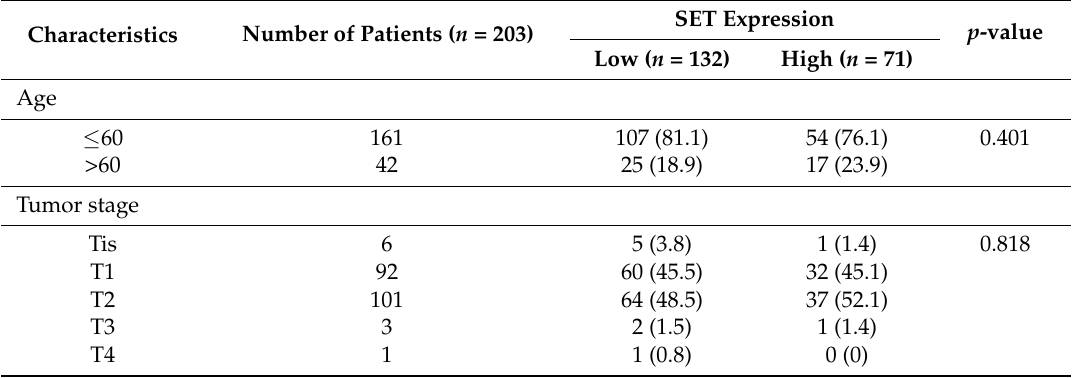
Table 3. Association of SET expression with clinico-pathological characteristics in 203 breast cancer